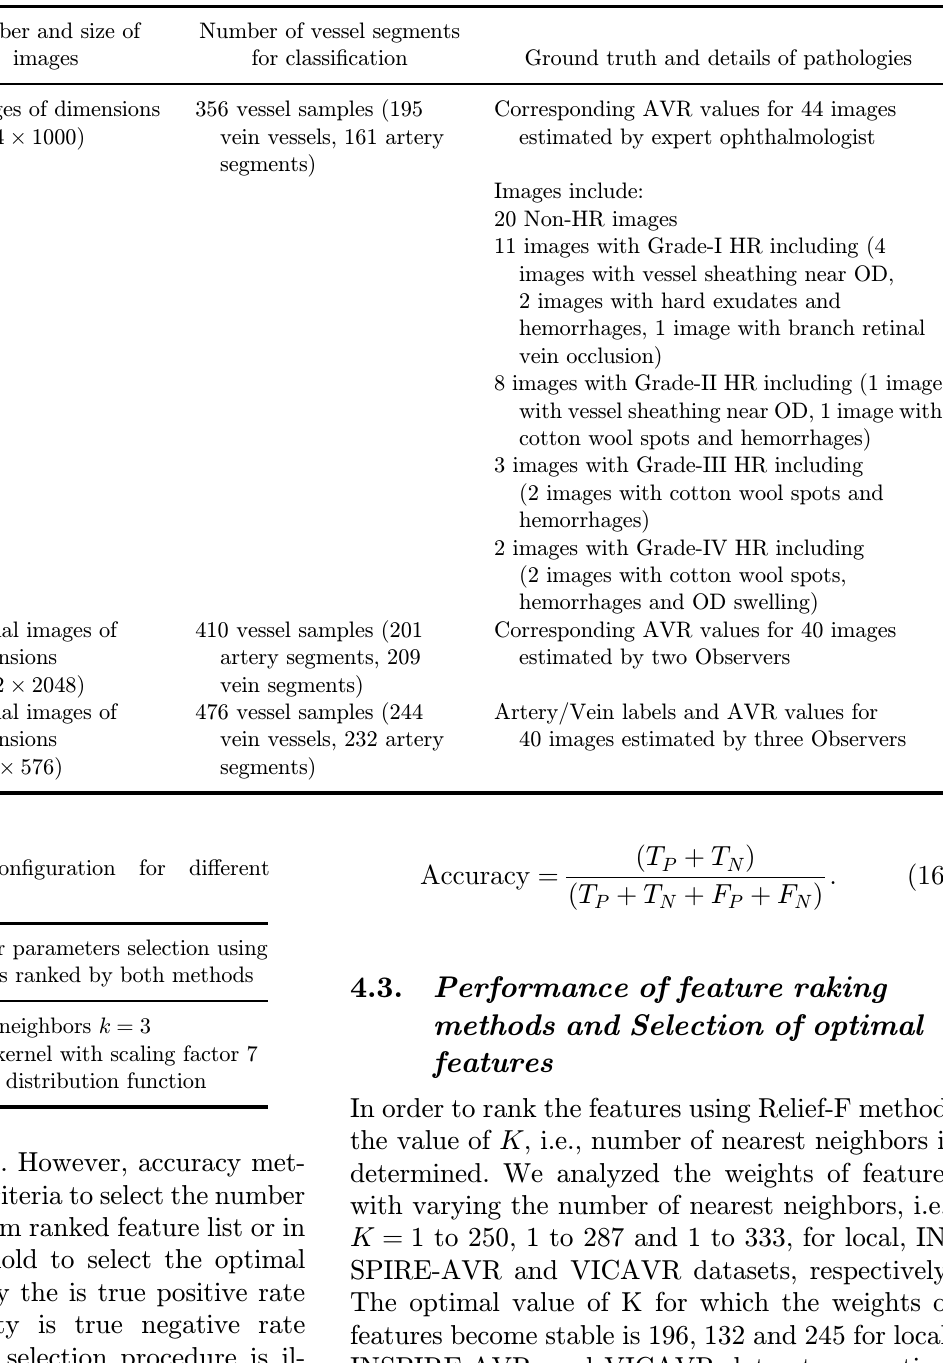
Table 2. Speci¯cations of